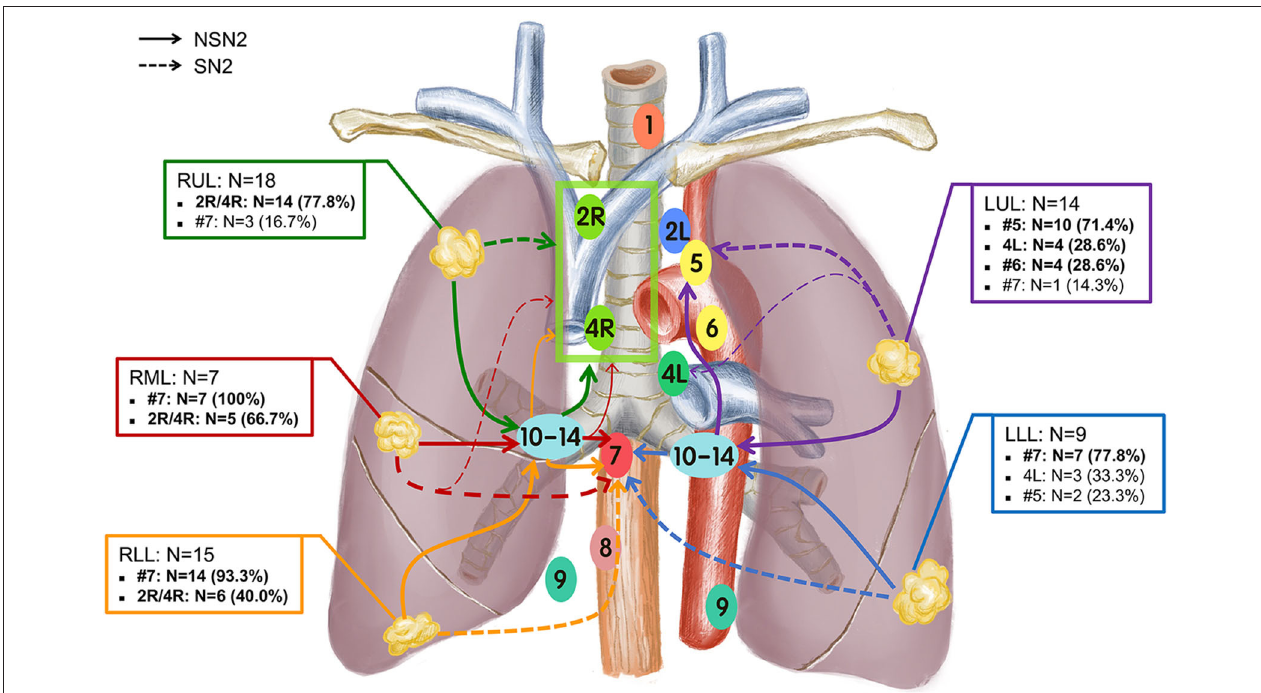
FIGURE 1 | Lobe-specific nodal drainage stations in patients with small-size NSCLC ( N = 63). The main drainage pathways of nodal metastases for each tumor location lobe were plotted using different colors.